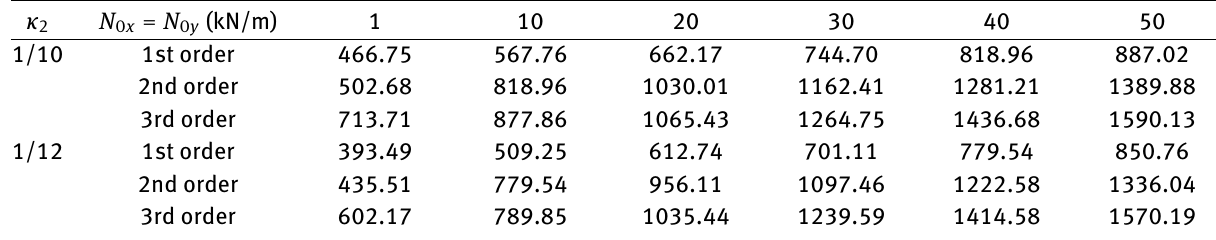
Table 2: The natural frequencies (rad/s) of analytical solutions under different prestress and rise span ratios κ